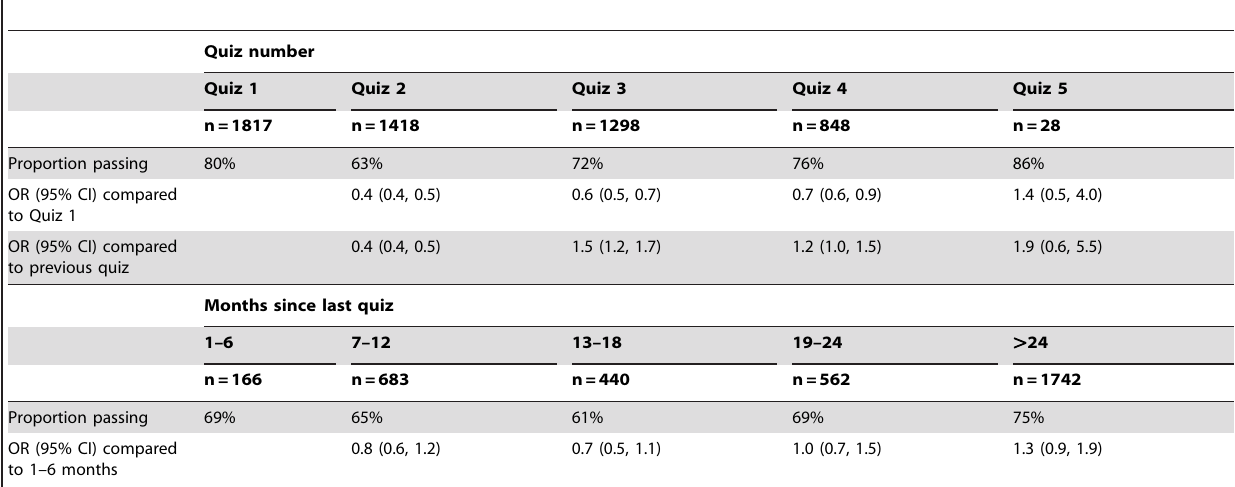
Table 3. Odds of passing comprehension quizzes 1–5 compared to quiz 1 & previous quiz; odds of passing comprehension quizzes 1–5 by time since last quiz